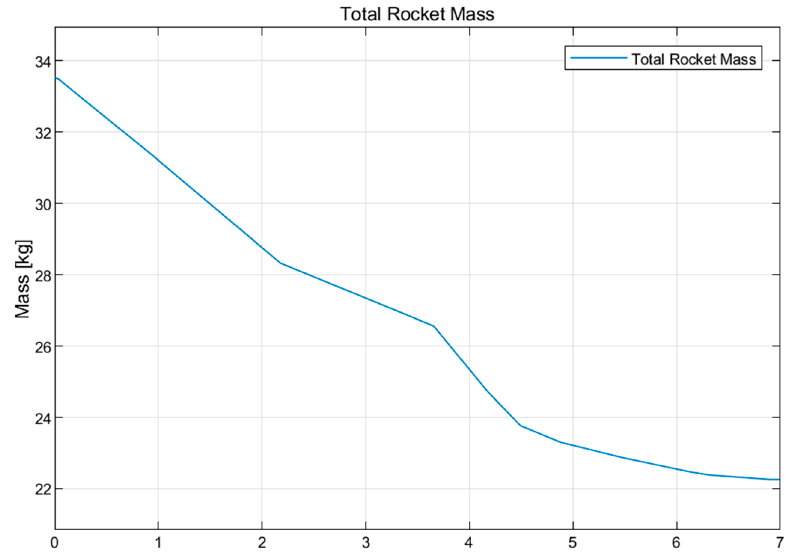
Figure 31. Pure Radial Mode Shape (X–Z Plane).